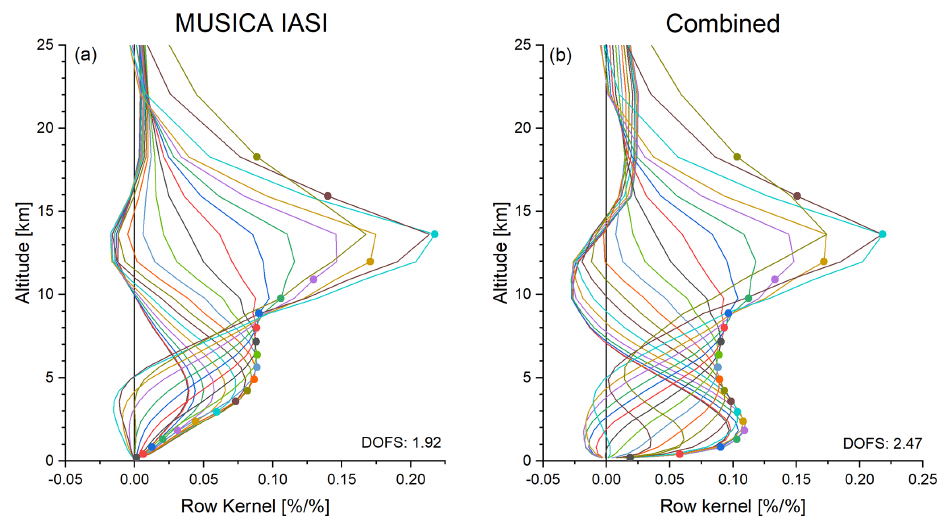
Figure 2. Logarithmic-scale row kernels for (a) the MUSICA IASI and (b) the combined product for the same late summer observations as used in the context of Figs. 1 and 3. The symbols mark the kernel values at the nominal altitude.